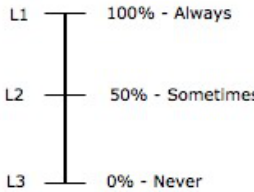
Figure 3. Level descriptor corresponding to the subcriterion with three levels descriptor